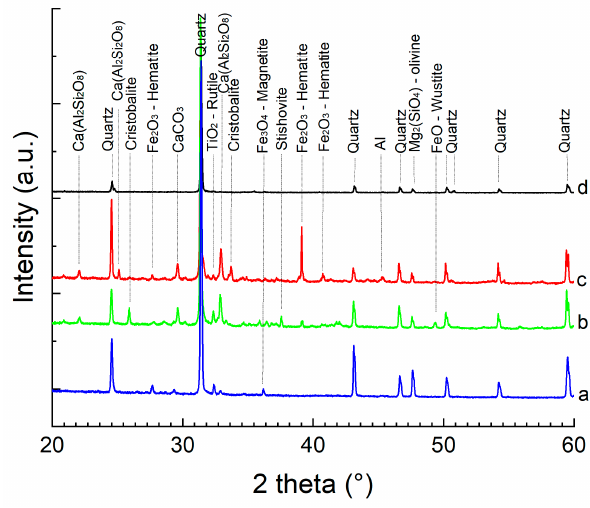
Figure 11. X-ray diffraction patterns recorded for the sample with 200 µm after sieving ( a ) and for the particles removed by low energy magnet ( b ), high energy magnet ( c ) and nonmagnetic fraction ( d ).